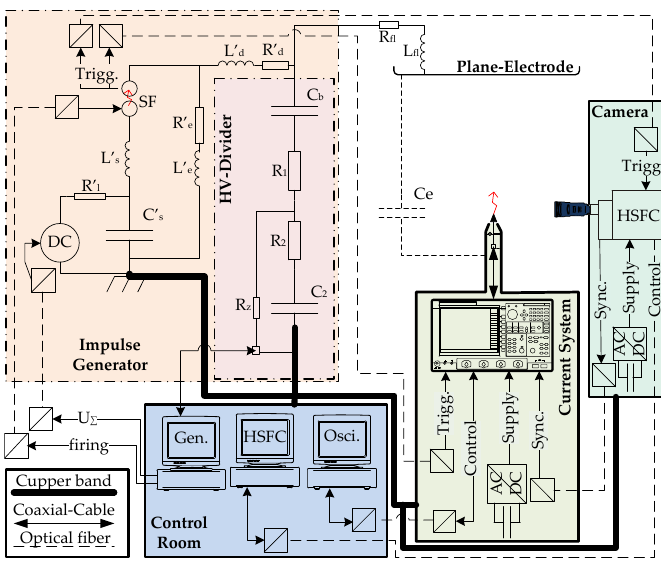
Figure 5. Electrical and optical measurement system out of [25]. Figure reproduced with permission from S HIRVANI , [25]; published by IEEE, 2013.